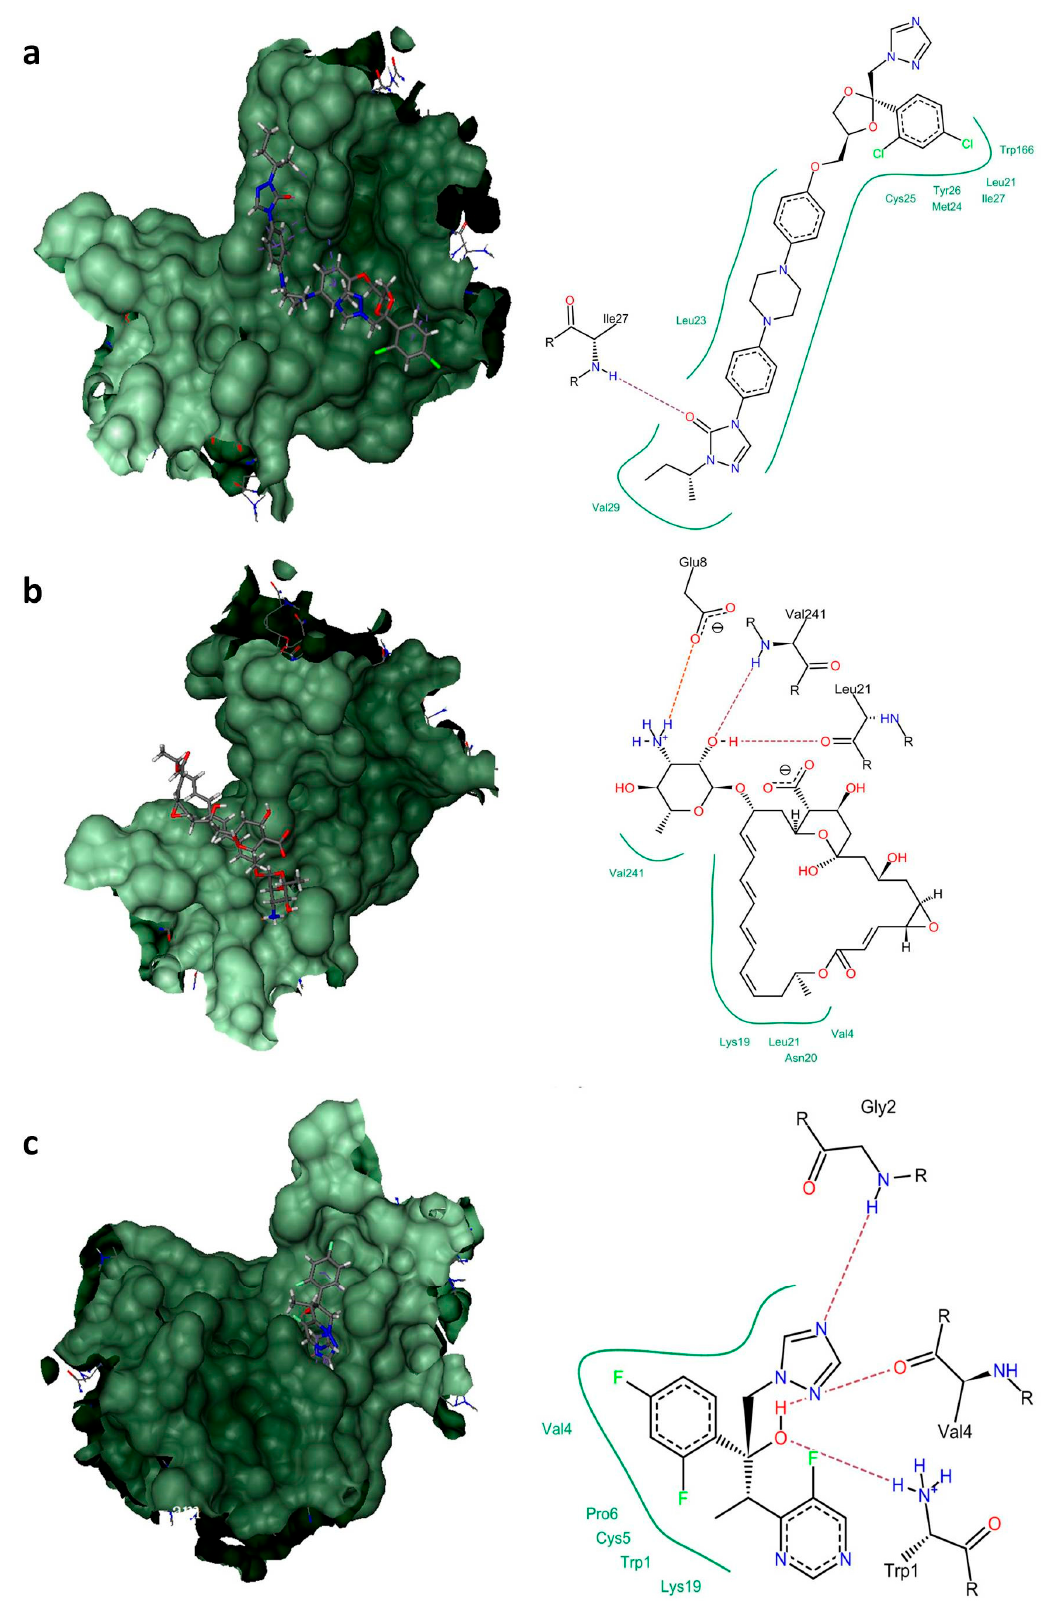
Figure 5. The docking complex and interactions of the best docked compounds with RNAP from A. fumigatus . ( a ) Itraconazole (Binding energy: − 13.7000 kJ/mol); ( b ) Natamycin (binding energy: